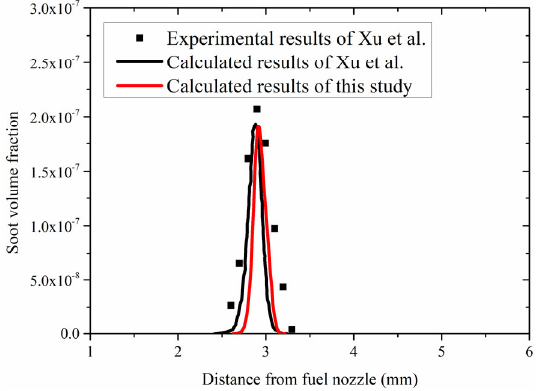
Figure 3. Calculated and experimental SVF profiles of SFO flames.